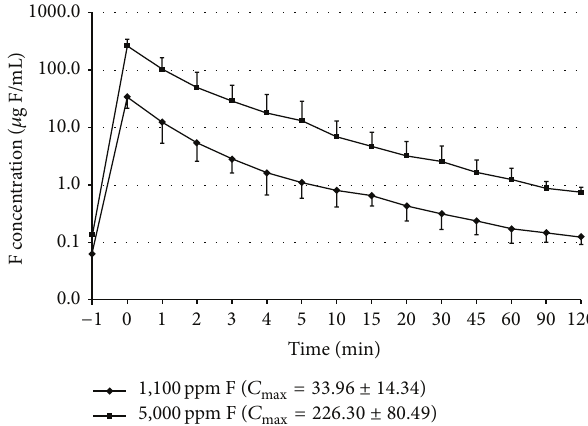
Figure 1: Salivary F concentration (mean ± SE) after the use of 1,100 or 5,000 𝜇 g F/g dentifrices. Baseline values are plotted at time − 1. F concentration values are plotted in log scale. Values were statistically different between dentifrices except in baseline ( 𝑃 < 0.001 ). 𝐶 max (mean ± SE) is shown at the